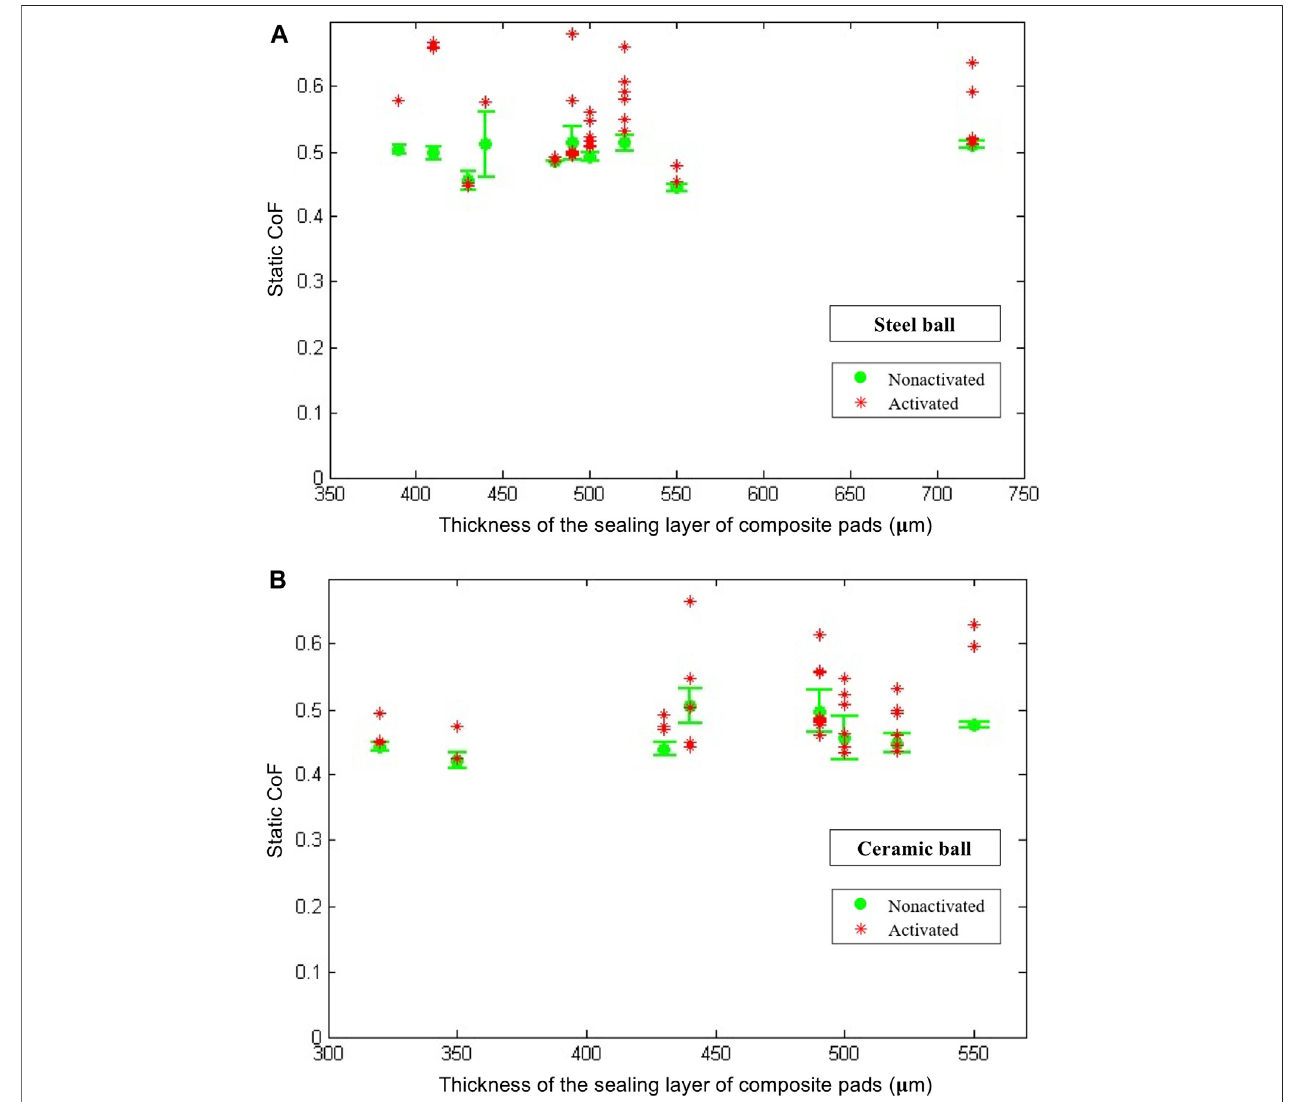
FIGURE 8 | Static CoF between samples with different upper layer thicknesses and the steel/ceramic ball. At least three samples are tested for each of the nonactivated cases.